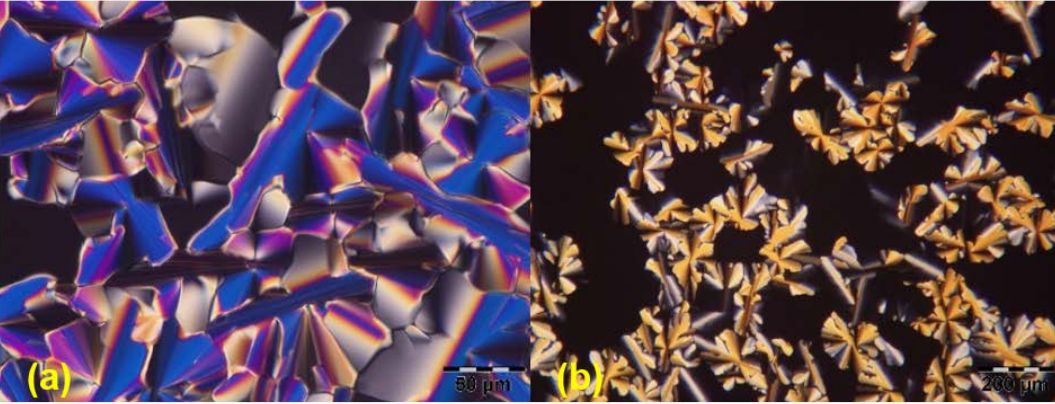
Figure 6. POM of t -66 : ( a ): at 84 ◦ C; ( b ): fan and homeotropic orientation at 65 ◦ C.